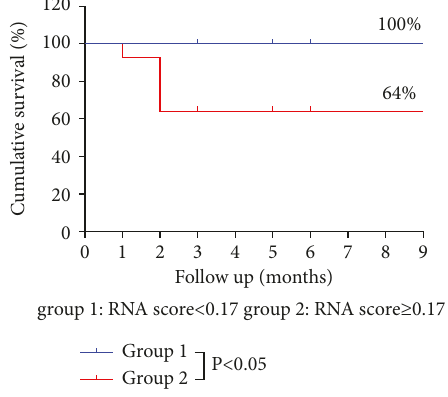
Figure 4: The survival curves were plotted based on the RNA scores used for evaluating the